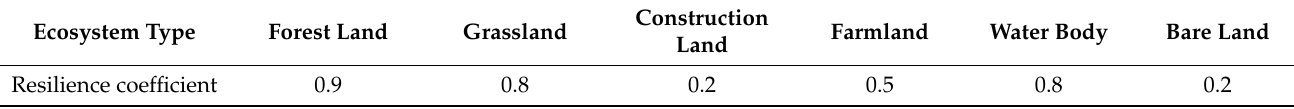
Table 4. Ecosystem resilience coefficient of land use